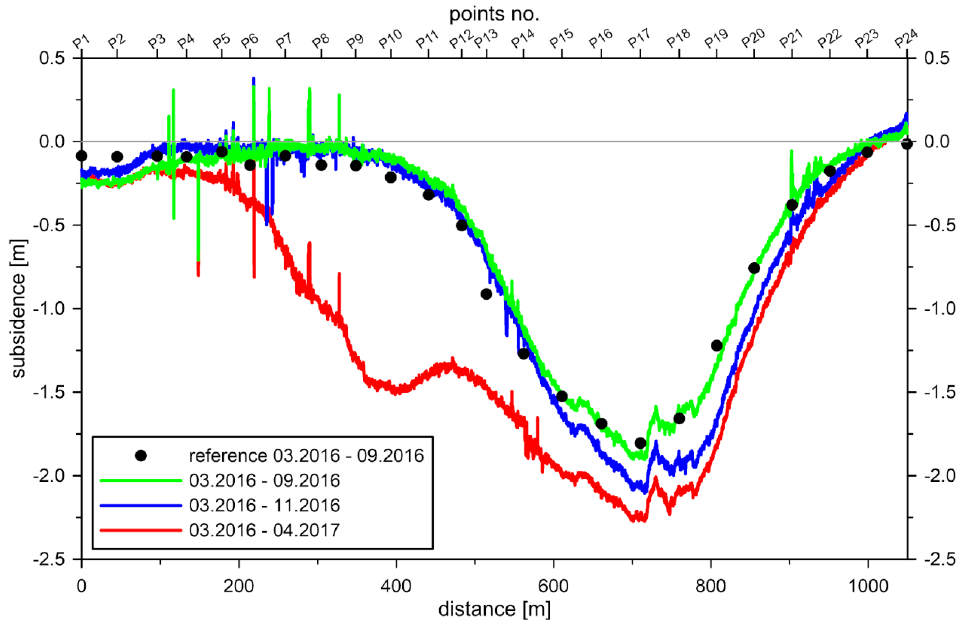
Figure 5. A profile of Piekary site subsidence along the P profile (marked by blue line in figure 1) based on UAV photogrammetric data is compared to reference measurements.